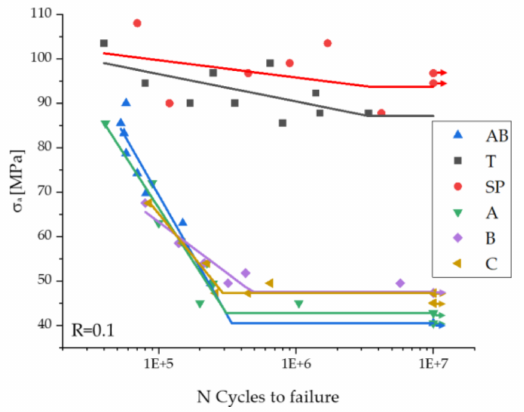
Figure 8. Results of the fatigue tests with R = 0.1 for the post-process treatments turning (T) and shot peening (SP) in comparison to specimens with as-built surface (AB) gathered with the bead string method acc. to DIN 50100 [53]. Run-throughs are marked with an arrow. Fatigue results of the in-process treatments of contour parameter A, B, and C in comparison to turned specimens (T) and as-built surface specimens (AB). The lines are only for